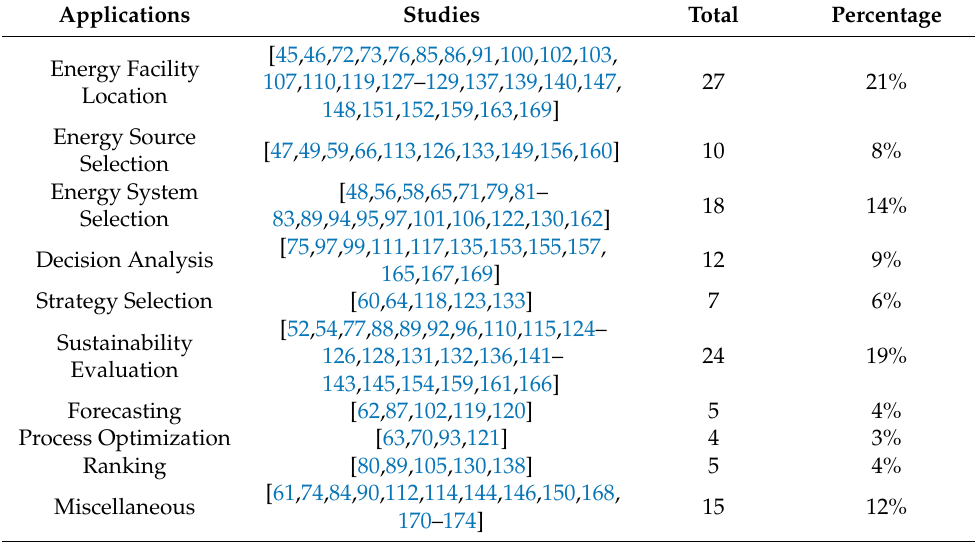
Table 8. Distribution of papers based on different applications in the CES